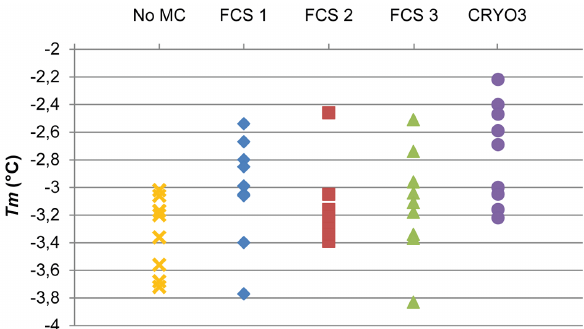
Figure 1. Diagram of the T m values for the cryopreservation solutions. MC: macromolecular component; FCS: foetal calf serum.